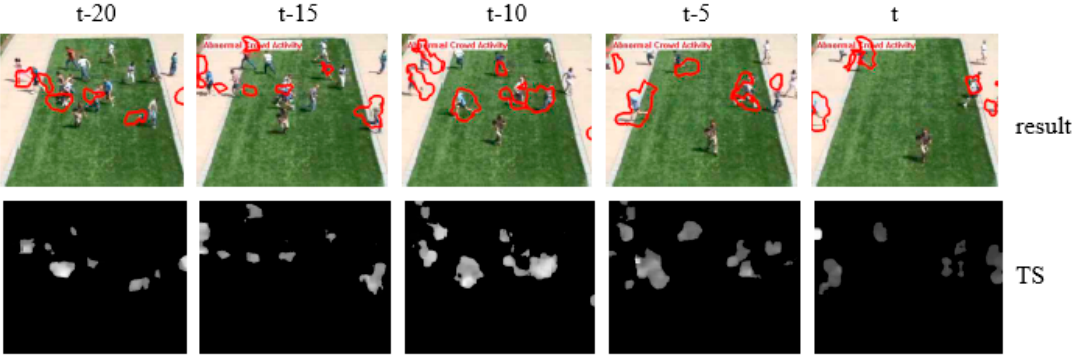
Figure 8. Examples of detection results for abnormality from No. 1 data (UMN Scene 1: Lawn).